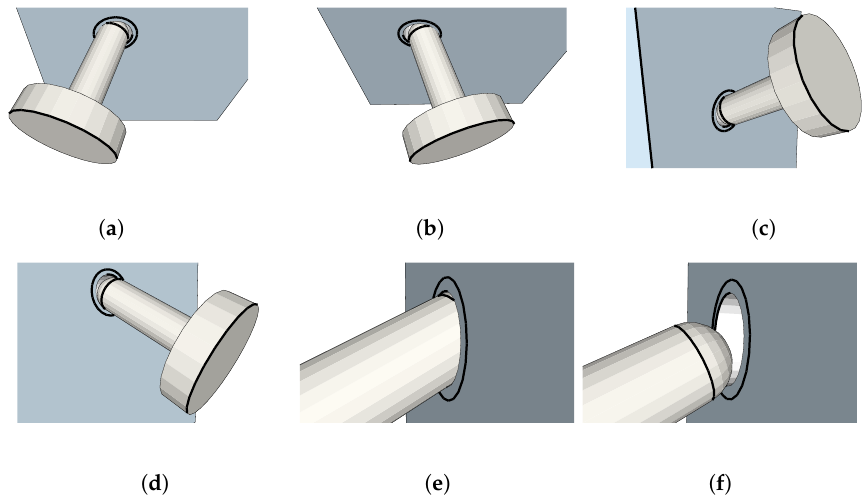
Figure 6. Initial training positions: ( a – d ) four different insertion positions to cover a circle over the hole; ( e ) initial position of the surface contact gesture; and ( f ) initial position of the lever effect gesture.